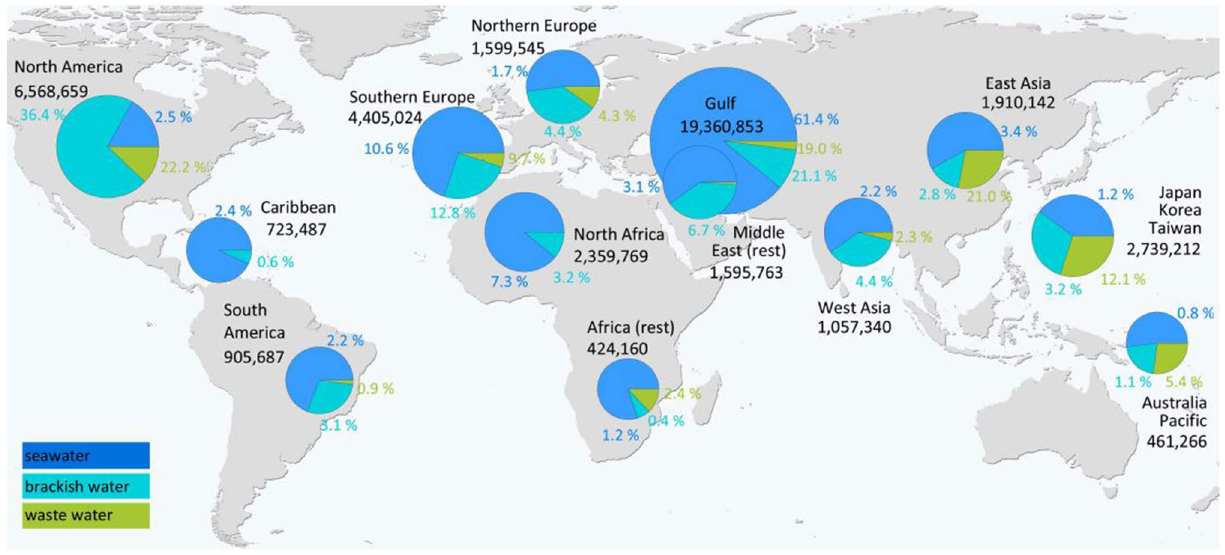
Fig. 4 International desalination capacity [m 3 /d, %] and which the Middle East has the largest share (Latteman 2010)